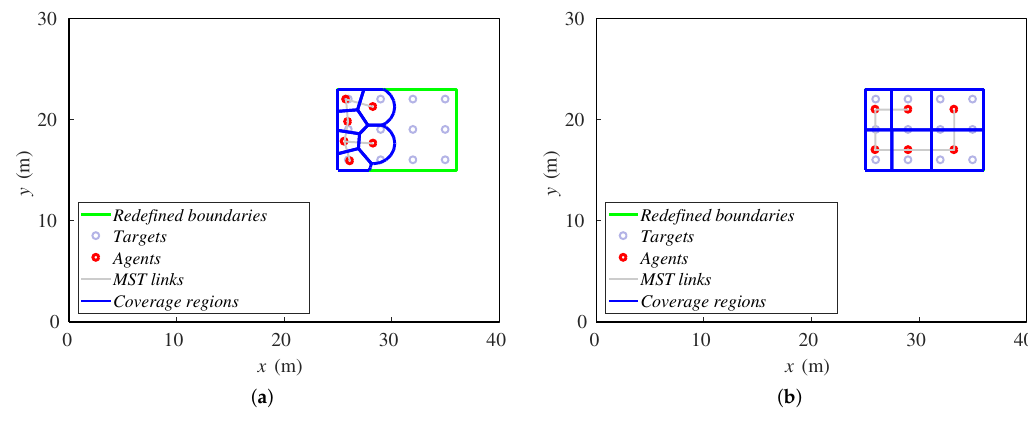
Figure 8. Final positions of agents and targets for ( a ) 2 m and ( b ) 3.5